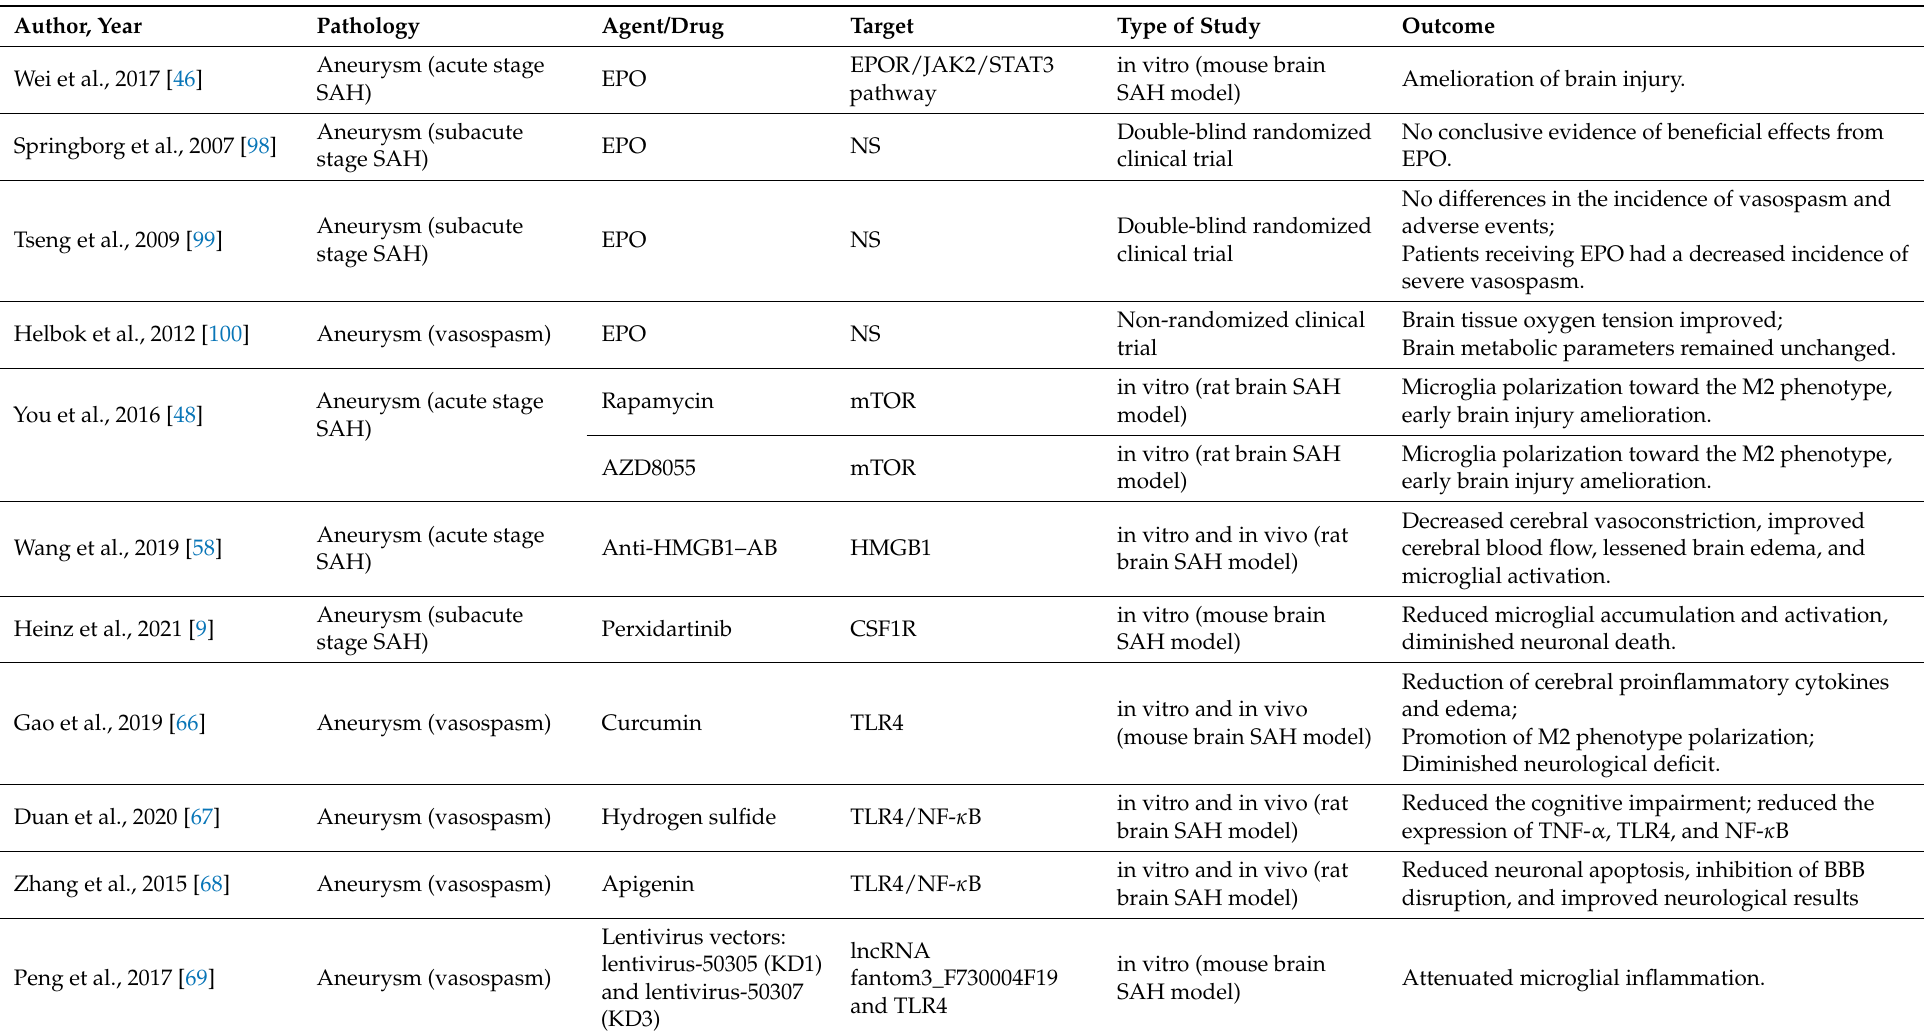
Table 1. Potential microglial-targeted treatment agents in cerebrovascular